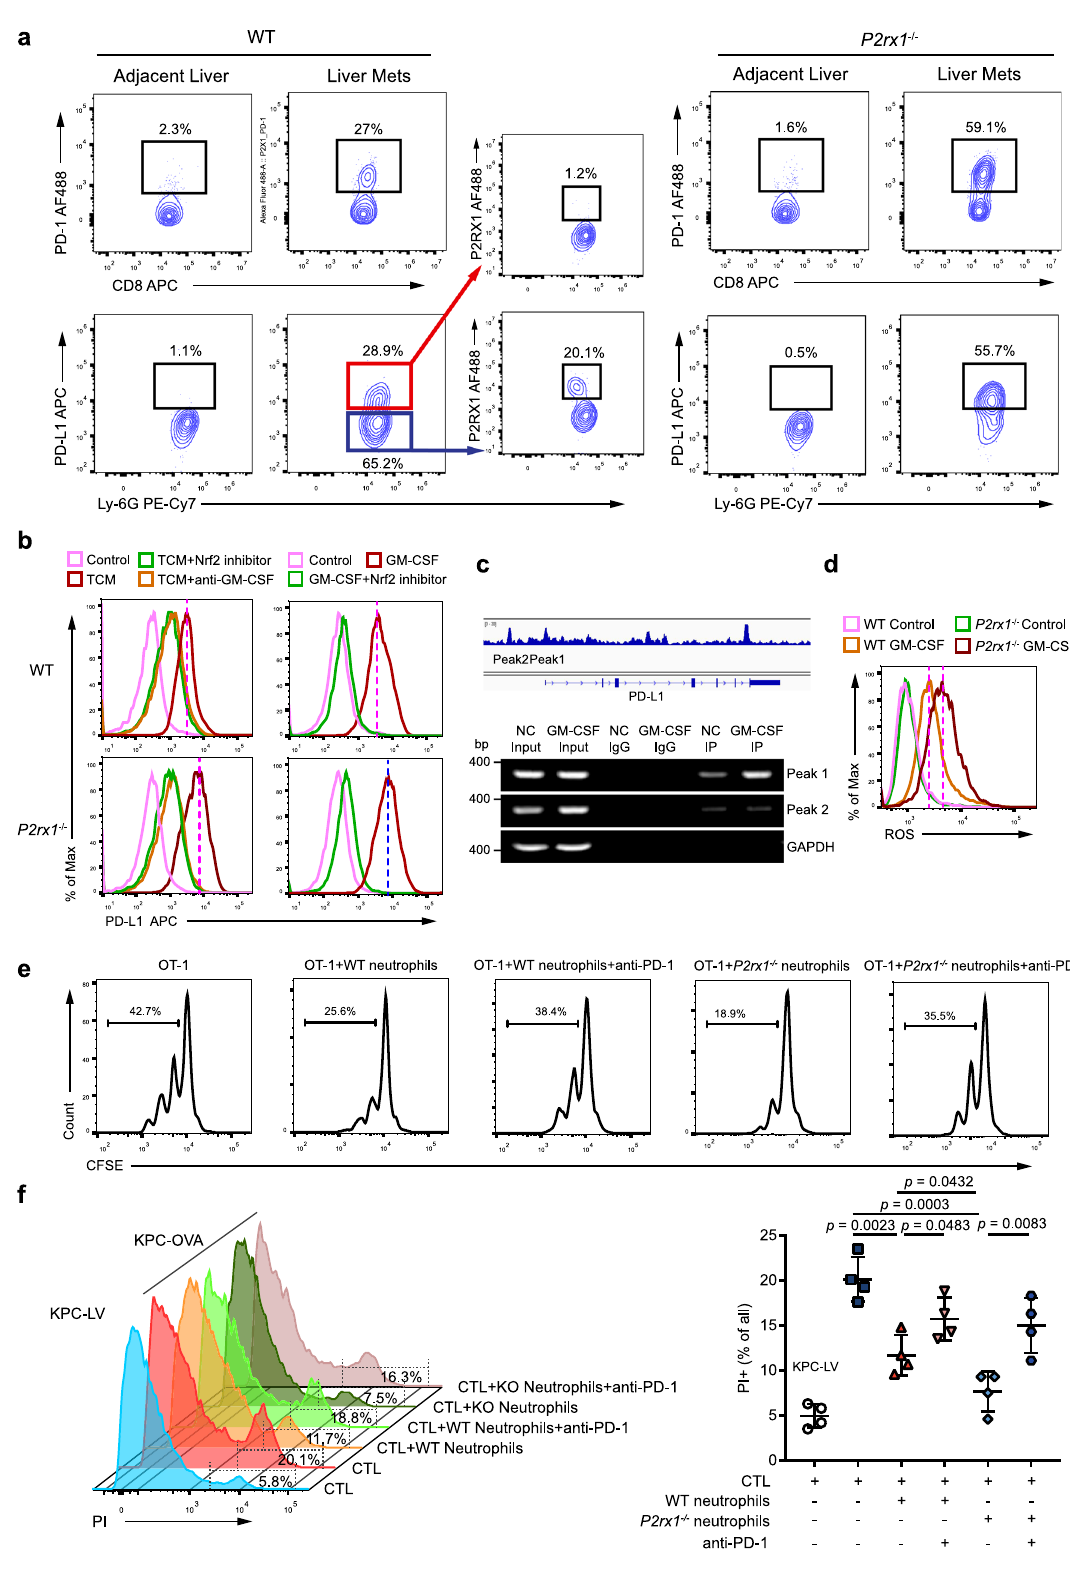
frequently supports immunostimulatory responses,